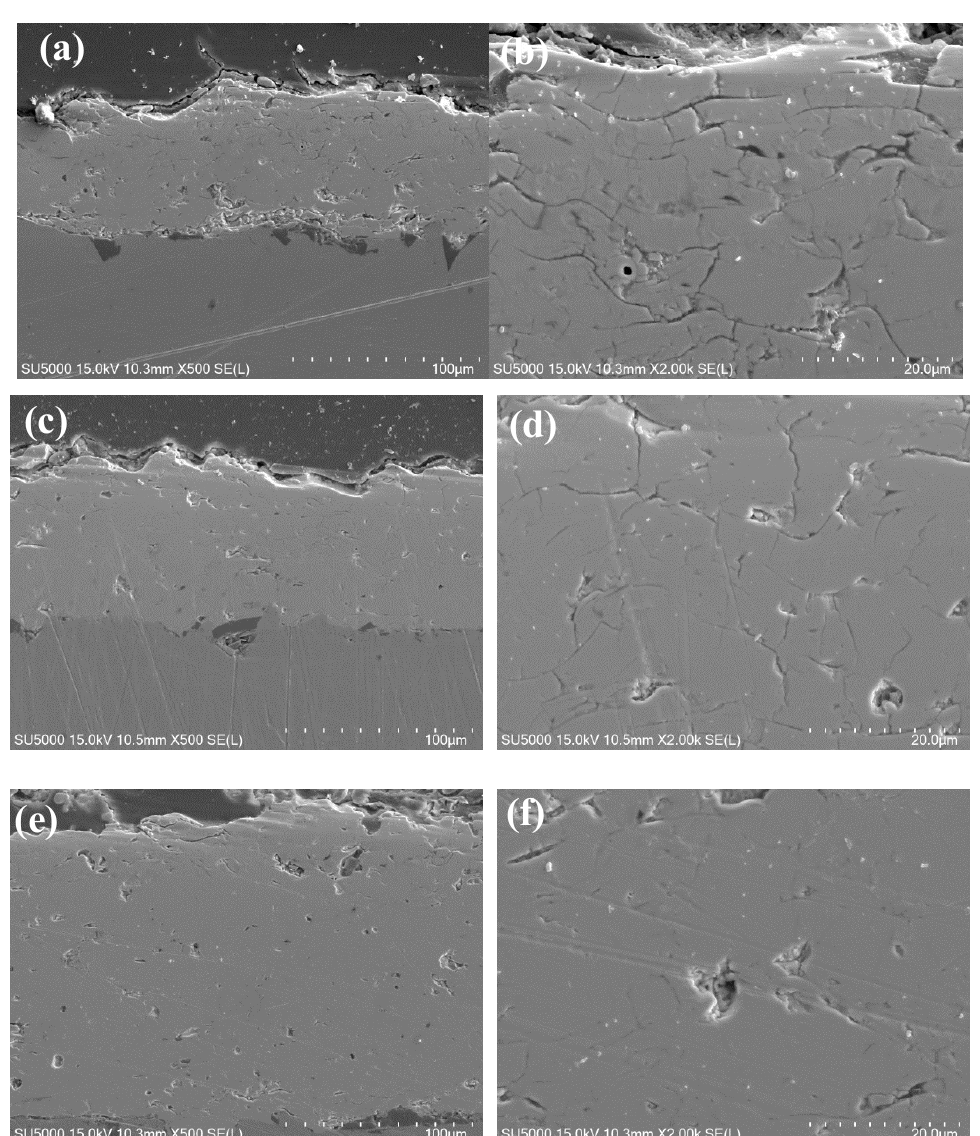
Figure 5. Cross-section morphologies of thermal barrier coatings deposited using different spray power: ( a , b ) 38 kW, ( c , d ) 42 kW, and ( e , f ) 46 kW.